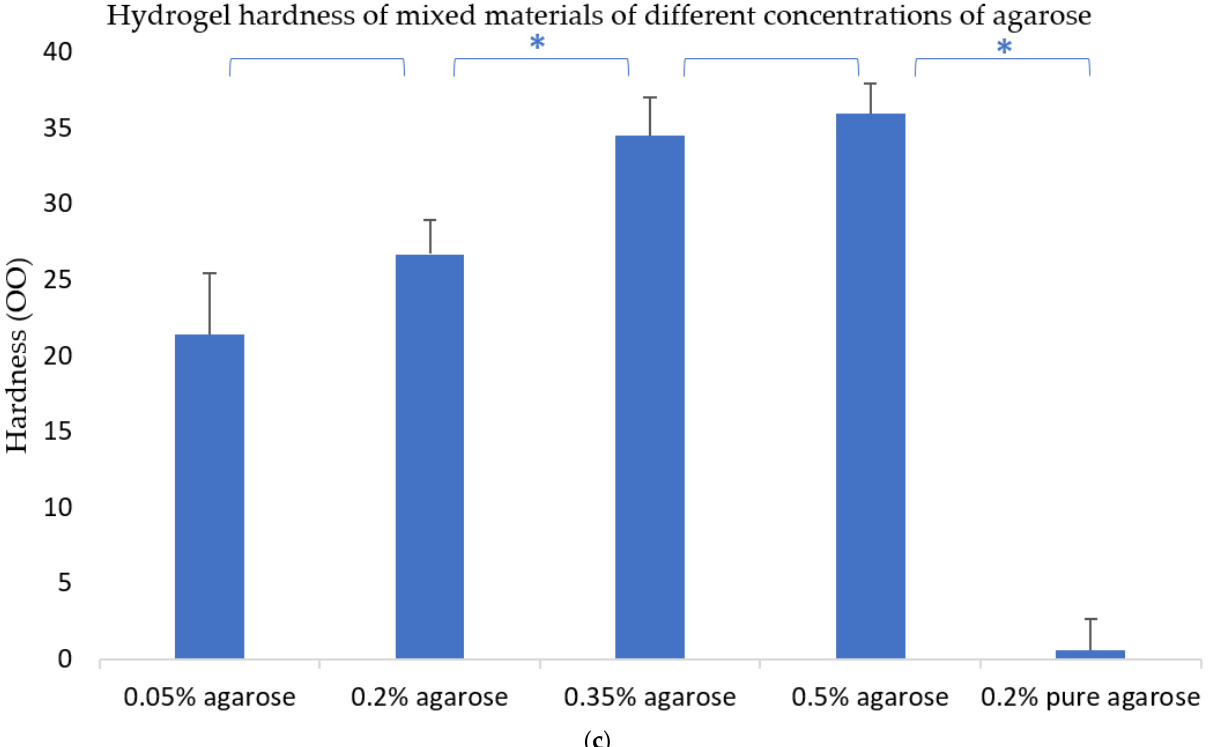
Figure 3. Hardness of the hydrogels. * means that there are statistical significances between the two adjacent gelatin–alginate–agarose concentrations. ( a ) Hydrogel hardness of mixed materials of different concentrations of gelatin. ( b ) Hydrogel hardness of mixed materials of different concentrations of sodium alginate. ( c ) Hydrogel hardness of mixed materials of different concentrations of agarose.